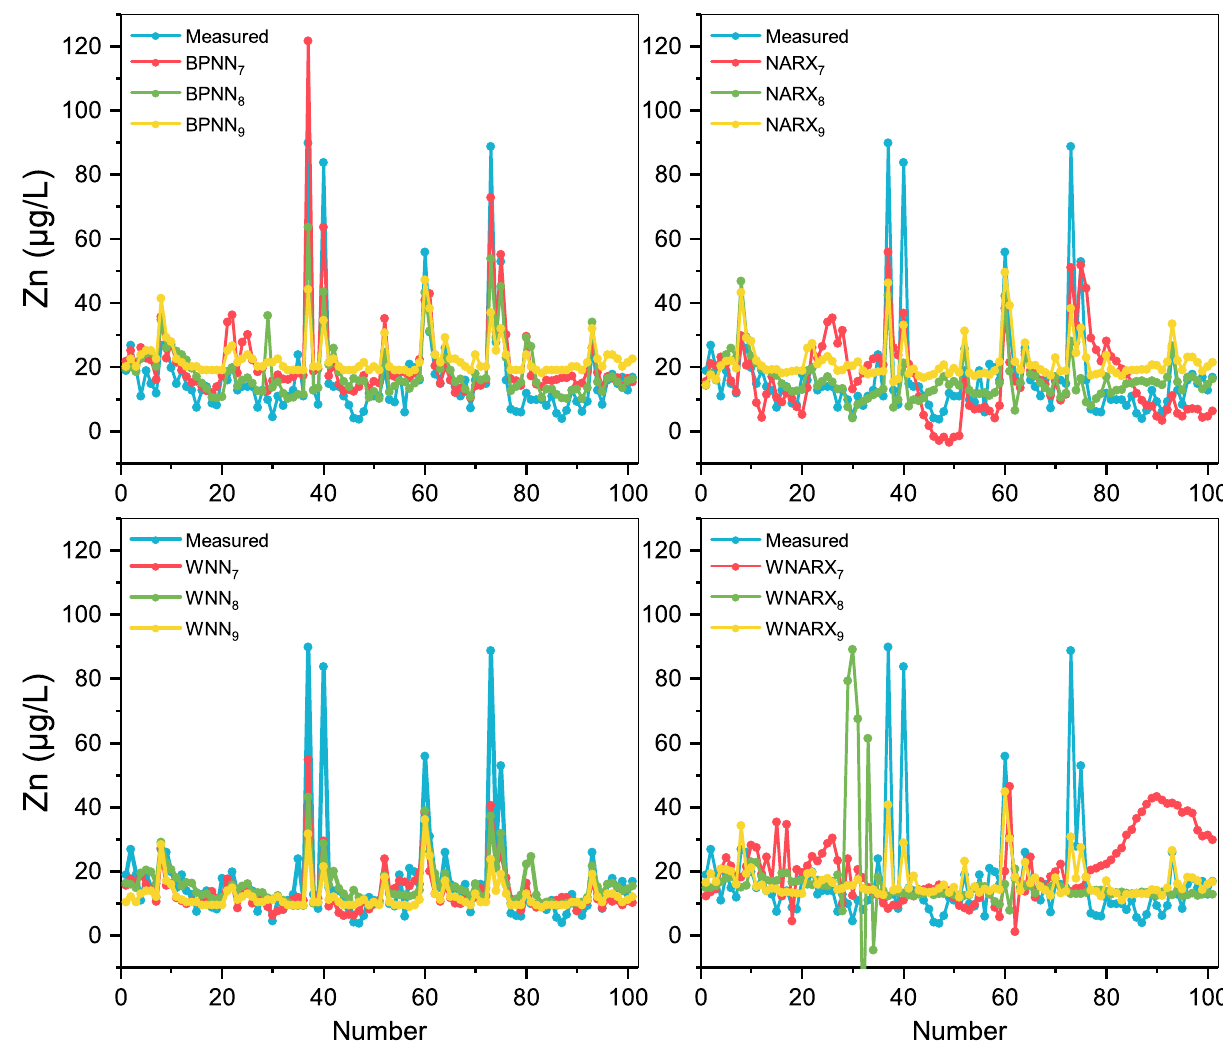
Figure 5. Comparison of the forecasting values and the measured values for Zn. This figure shows the different prediction results for Zn of the settings of the best model parameters in each model algorithm, indicating the concentration of Zn changes within 2 years’ measurement. The red represents the situation with inputs: Fe, flow, pH, NO 3 –N, and EC, the green represents the situation with inputs: Fe and NO 3 –N, and the yellow represents the situation with inputs: